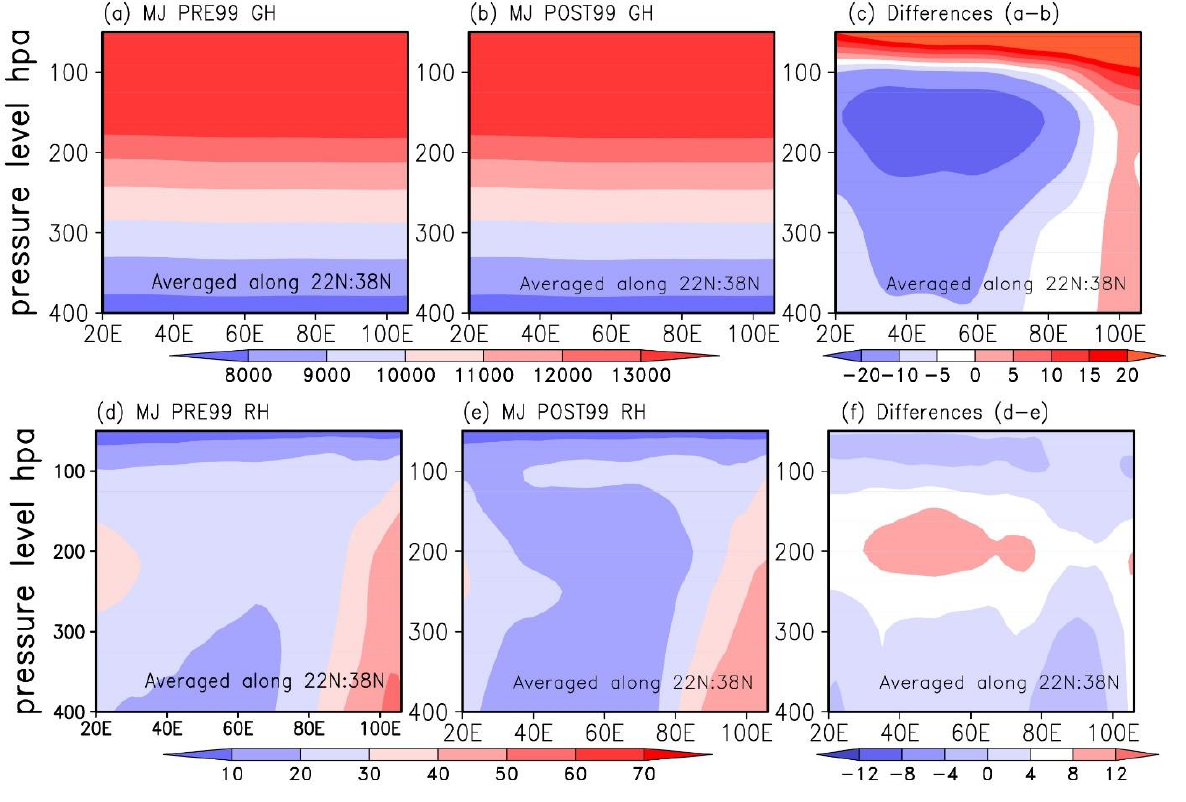
Figure 5. Vertical variation in the geopotential height over the latitudinal band 22 ◦ N–38 ◦ N ( a ) PRE99 and ( b ) POST99. ( c ) The difference between ( a , b ), that is, (a) − (b). ( d – f ) as in ( a – c ), but for relative humidity.